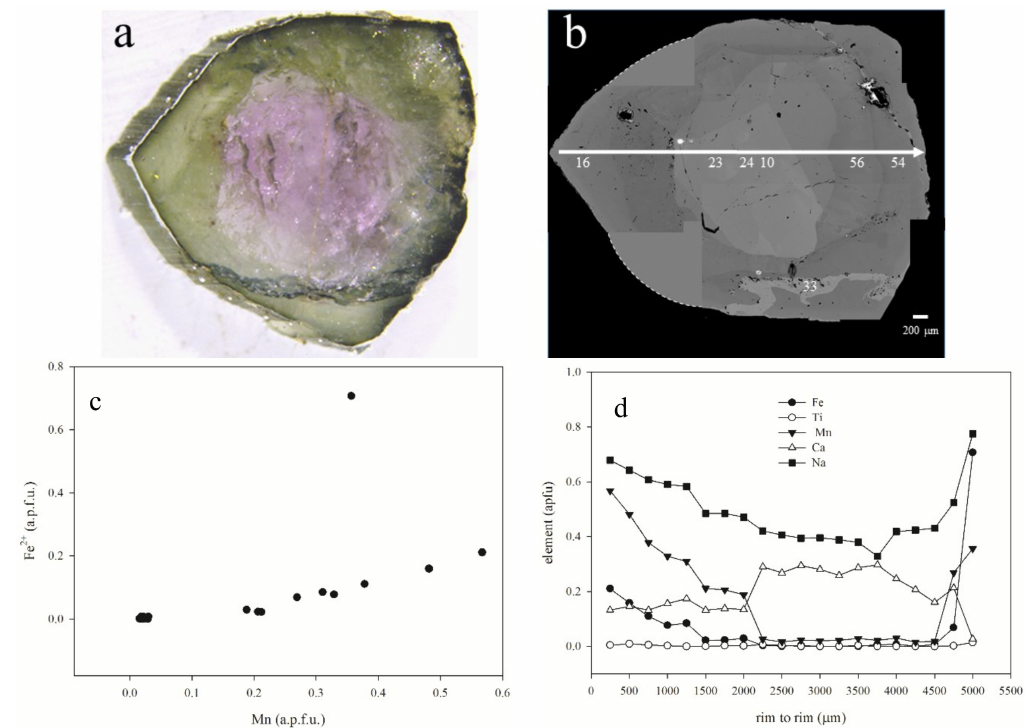
Figure 9. Optical microscope ( a ) and BKSE ( b ) images, ( c ) variation of Fe vs. Mn and ( d ) an example of zoning patterns of different elements of sample 4. The points in BKSE image correspond to the points reported in Table 2.